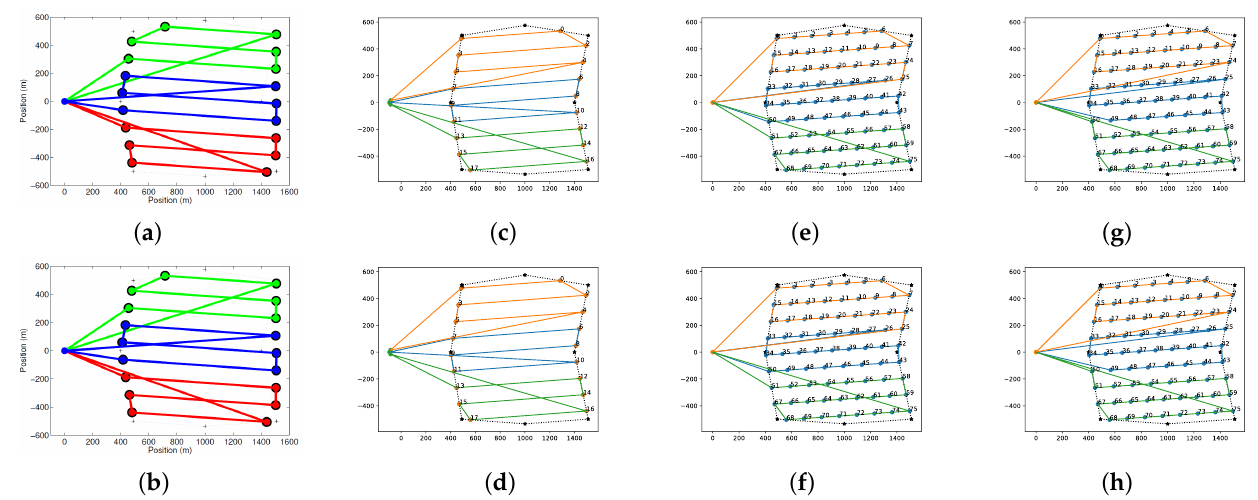
Figure 9. Multi-UAV routing comparison results with 3 UAVs: ( a ) results obtained with graph optimization for fixed wings; and ( b ) results obtained with graph optimization for multirotors; Figure 9. UAV multi-UAV routing comparison results with 3 UAVs. (a) Results obtained with graph ( c , d ) SIMPLE-BINPAT; ( e , f ) BINPAT; and ( g , h ) POWELL-BINPAT. optimization for fixed wings (b) Results obtained with graph optimization for multirotors. (c,d) In Figure 9, the results obtained with simple and sampled back-and-forth decomposi- SIMPLE-BINPAT. (e,f) BINPAT. (g,h) POWELL-BINPAT tion are compared with the graph optimization methods in the literature [26,27]. Although the constraints used for the optimization in these methods are different, the BINPAT al- gorithm with simple area decomposition generates similar trajectories compared to these proposals. Moreover, using the approaches with sampled area decomposition, these results are improved for our specific constraints. Furthermore, the processing time was evaluated Figure 9. UAV multi-UAV routing comparison results with 3 UAVs. (a) Results obtained with graph in a computer with an AMD Ryzen 7 3750H processor and 16-GB RAM, as shown in Table 3. optimization for fixed wings (b) Results obtained with graph optimization for multirotors. (c,d) Table 3. Processing time results for a different UAV number. SIMPLE-BINPAT. (e,f) BINPAT. (g,h) POWELL-BINPAT UAVs